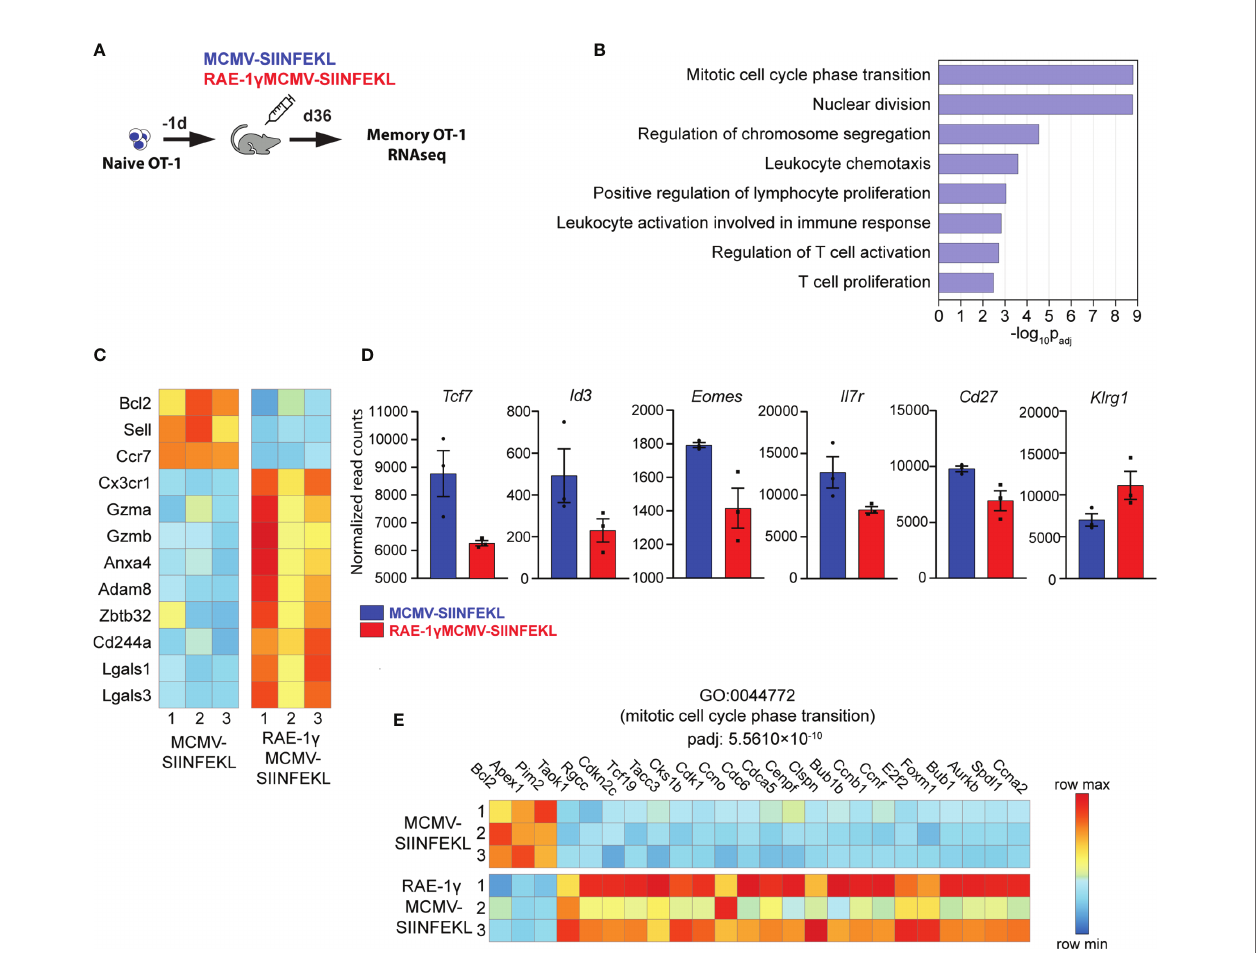
FIGURE 2 | Memory CD8 T cells primed with RAE-1 g MCMV exhibit a distinct transcriptional pro fi le. (A) 10 4 naive OT-1 cells were transferred to C57BL/6J mice one day prior to immunization with MCMV-SIINFEKL or RAE-1 g MCMV-SIINFEKL (n=3). (B) Gene ontology overrepresentation analysis (GO-ORA) of identi fi ed differentially expressed genes. Bar chart showing selected, statistically signi fi cant GO terms in the Biological process category, ranked by adjusted p-values. (C) Heat map showing the expression of indicated genes. (D) Transcription of indicated genes below chosen signi fi cance threshold. (E) Heat map showing the expression of genes belonging to the GO term “ Mitotic cell cycle phase transition ” . Data are from a single experiment. Genes and GO terms with padj<0.05 were considered statistically signi fi